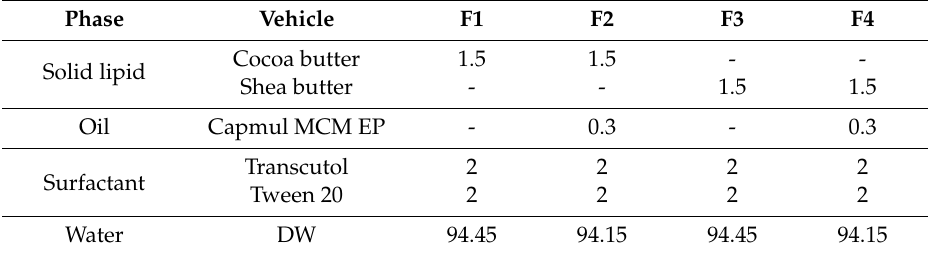
Table 2. Composition of solid lipid nanoparticle (SLNs) and nanostructured lipid carrier